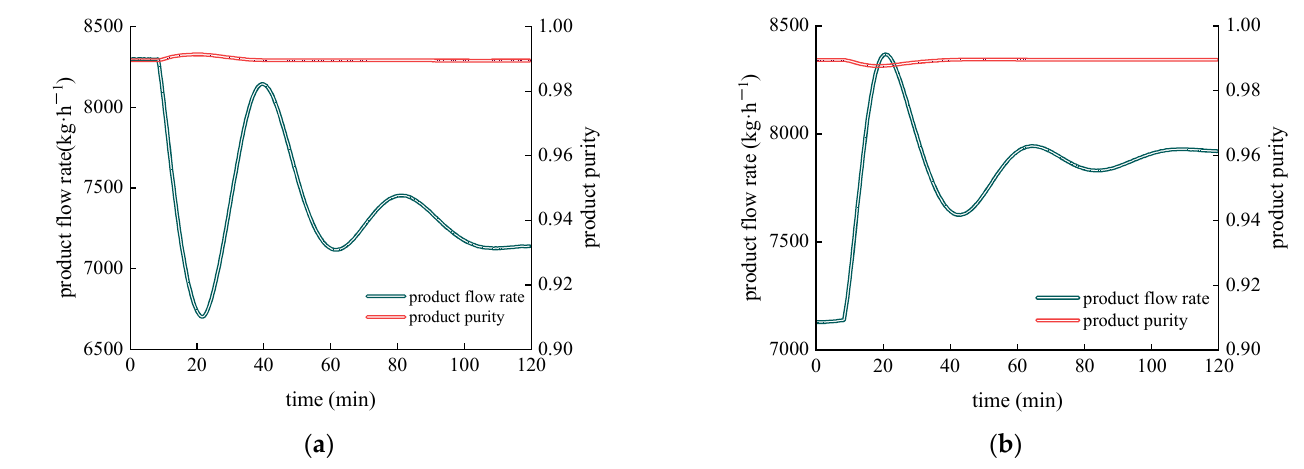
Figure 5. ( a ) Process ① product curve and ( b ) process ③ product curve.